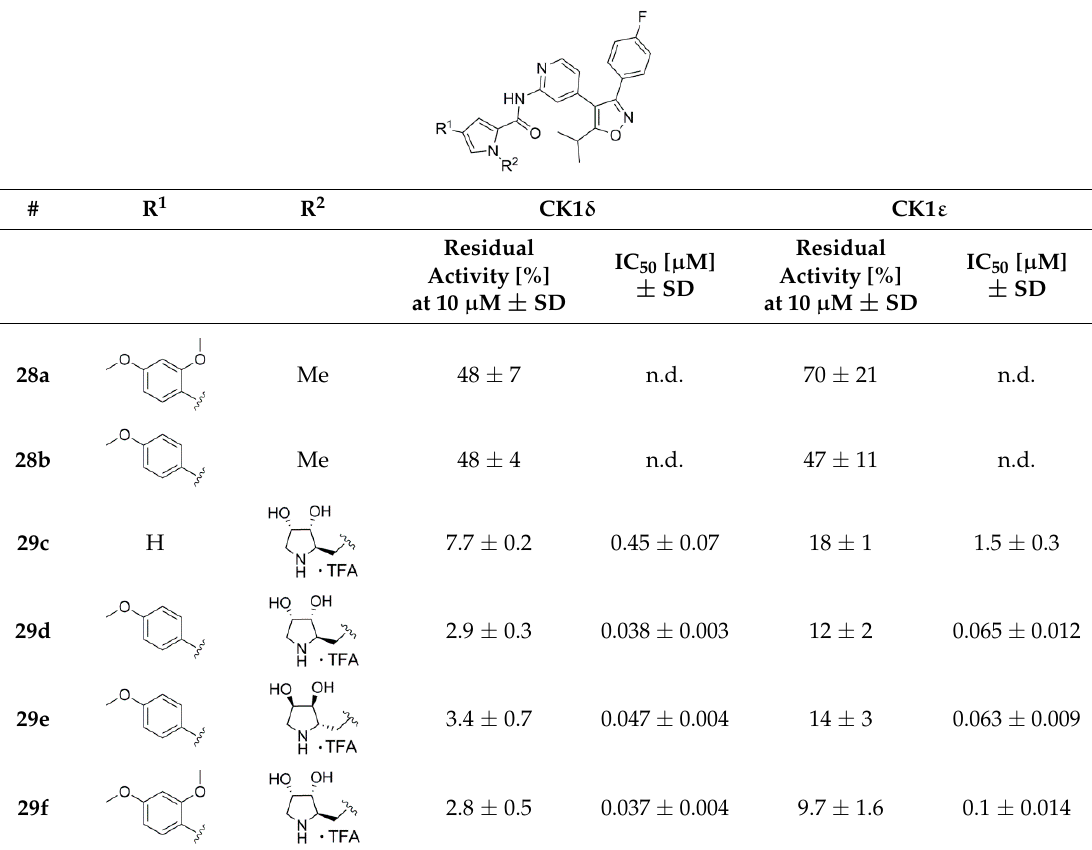
Table 1. Activity and IC 50 values of compounds 28a , b and 29c – f in CK1 δ and CK1 ε kinase assays. Results are presented as mean ± SD from experiments performed in triplicate ( n = 3).